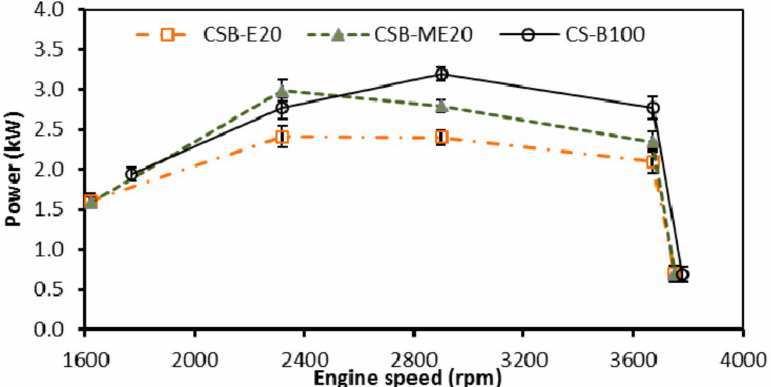
Figure 9. The relationship between engine speeds (rpm) and engine brake power (kW) for CS-B100, CSB-E20 and CSB-ME20.